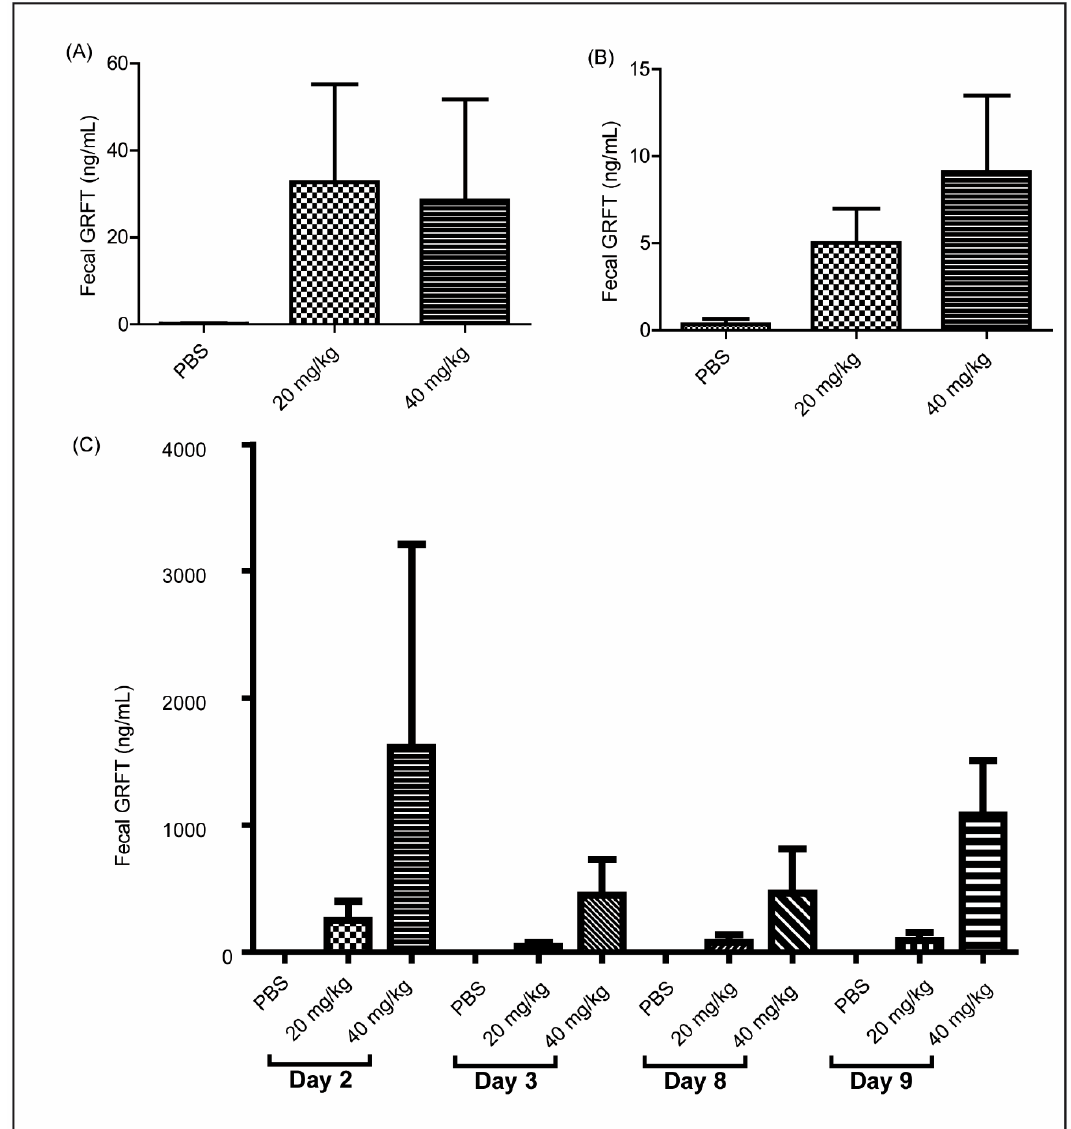
Figure 2. Fecal GRFT concentrations following chronic oral dosing. Fecal extracts were prepared from fresh fecal pellets obtained 8 h (n = 5) ( A ) and 24 h (n = 6) ( B ) after oral treatment with PBS, 20 mg/kg GRFT, or 40 mg/kg GRFT. Bars are mean ± standard deviation from five biological replicates. Fecal extracts (n = 3) were prepared from desiccated pellets randomly drawn from cages (two animals per cage) on indicated days ( C ); bars are mean ± standard deviation from three biological replicates.